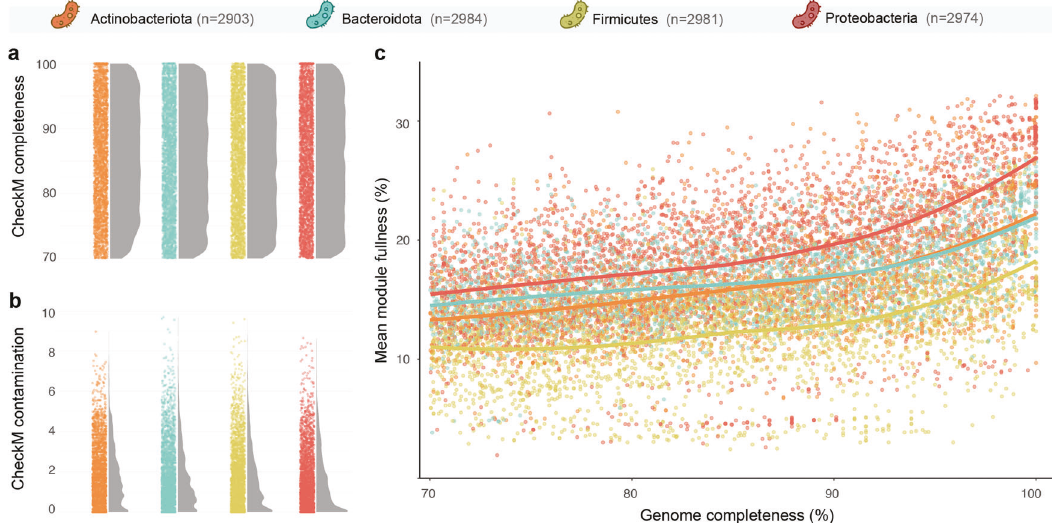
Fig. 1 General genome completeness, contamination and metabolic module fullness statistics. Distribution of CheckM completeness ( a ) and contamination ( b ) values of the genomes used in this study displayed as jitter plots and associated density curves. c Relationship between genome completeness and mean KEGG module fullness. Dots indicate individual genomes coloured by taxonomic phylum. Solid lines indicate LOESS smoothed mean for each